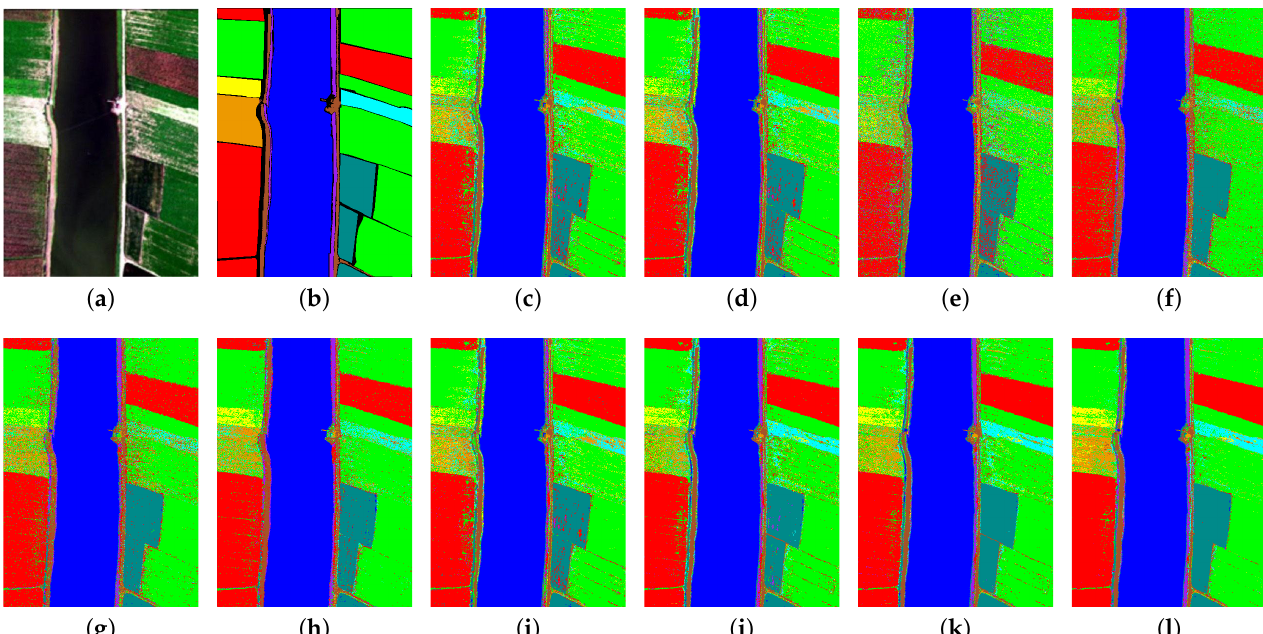
Figure 10. Classification maps for the whole scene on the LongKou data set. ( a ) False color image; ( b ) ground truth; ( c )